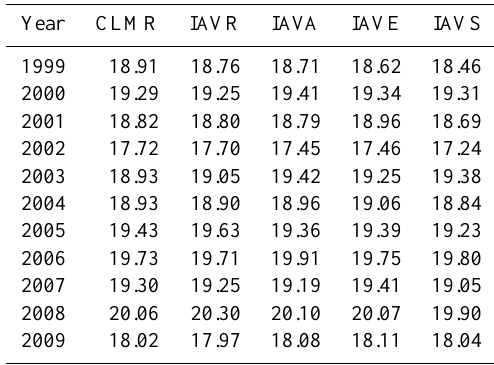
Table 7. Global total source strength (Tga − 1 N) for each of the sensitivity tests.